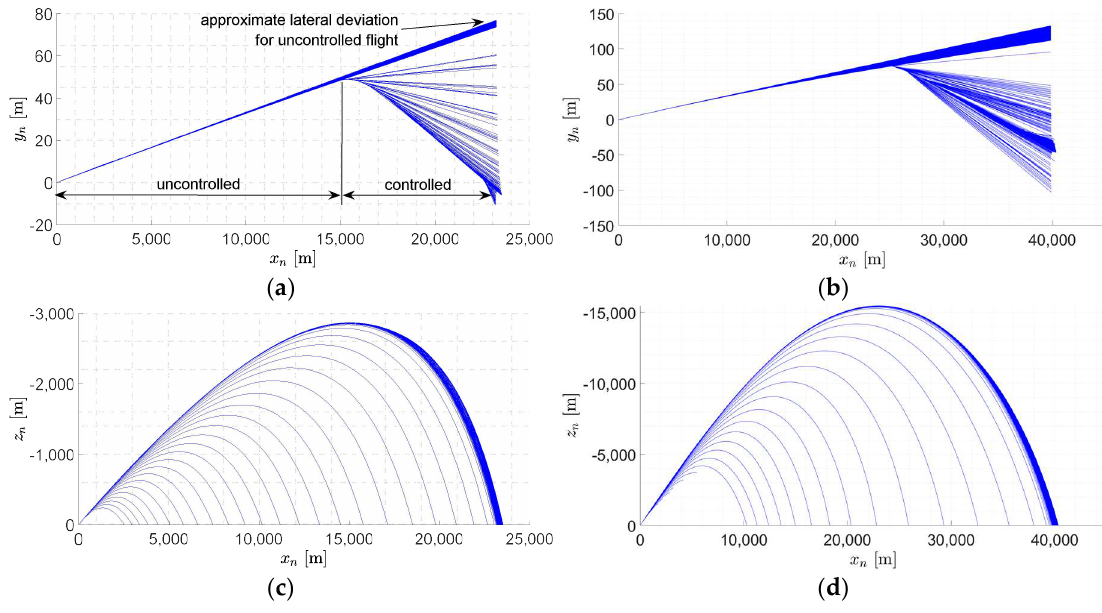
Figure 9. Predicted trajectories: cross-range vs. downrange for ( a ) Θ 0 = 20 ◦ ( b ) Θ 0 = 50 ◦ and altitude Figure 9 . Predicted trajectories: cross-range vs. downrange for (a) 𝜣 𝟎 = 20° (b) 𝜣 𝟎 = 50° and altitude vs. downrange for ( c ) Θ 0 = 20 ◦ ( d ) Θ 0 = 50 ◦ . vs. downrange for (c) 𝜣 𝟎 = 20° (d) 𝜣 𝟎 = 50°